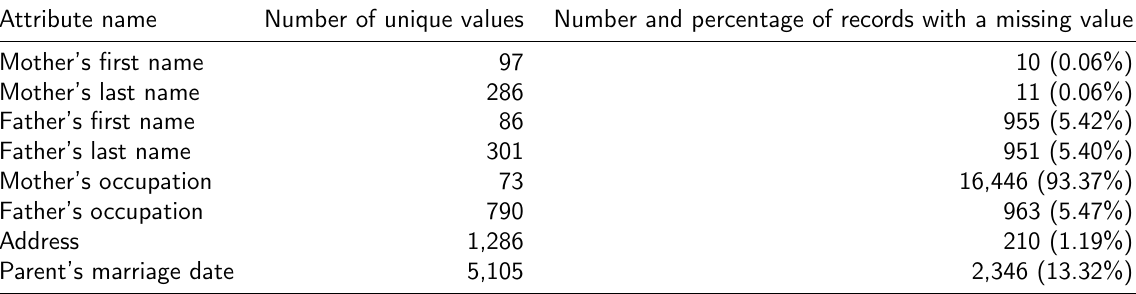
Table 5: Number of unique values and records with missing attribute values for different attributes in the Isle of Skye dataset.